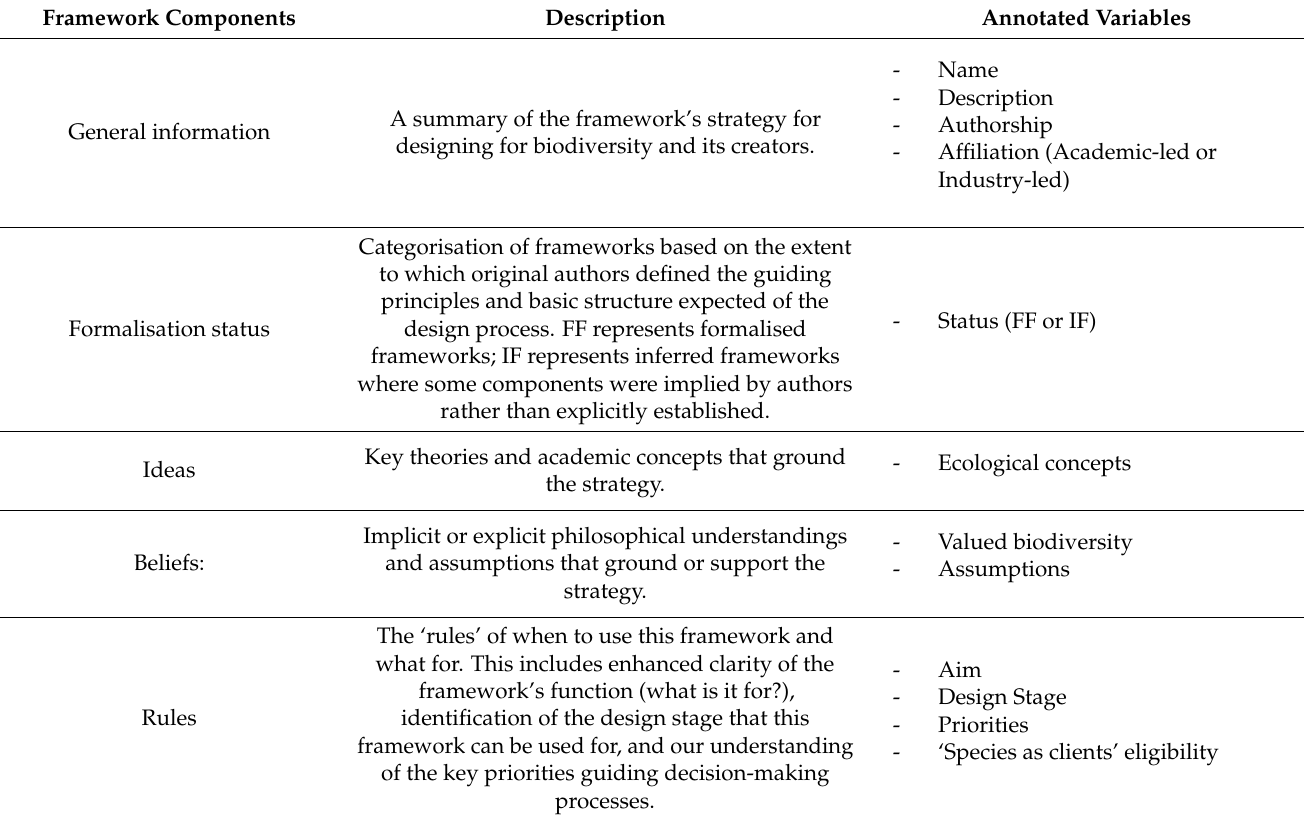
Table 2. Systematic review for each framework, including framework components, a description of those components and the variables